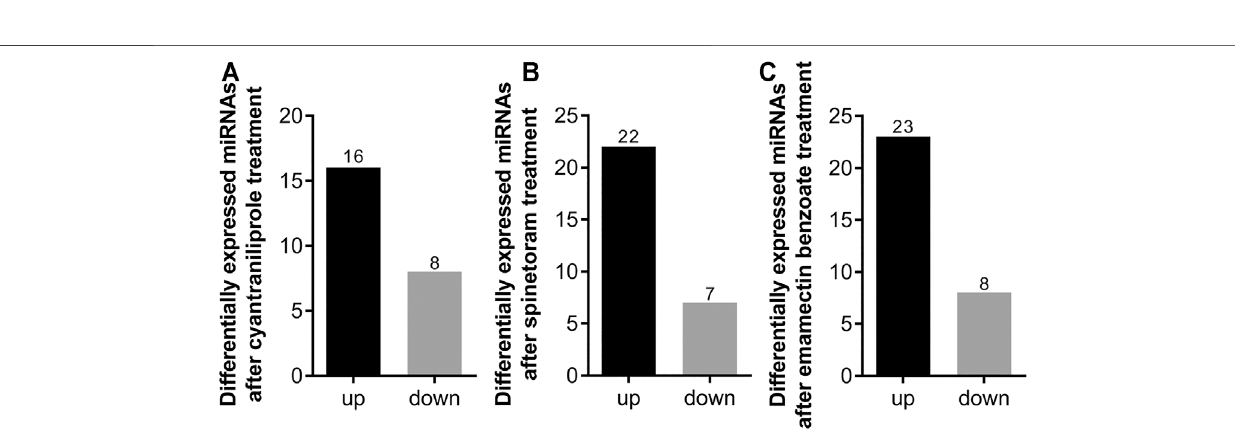
Frontiers in Genetics |